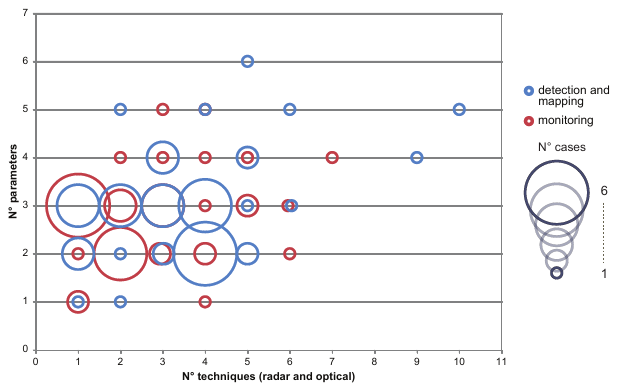
Fig. 4. Number of employed remote sensing techniques (radar and optical) versus number of observed